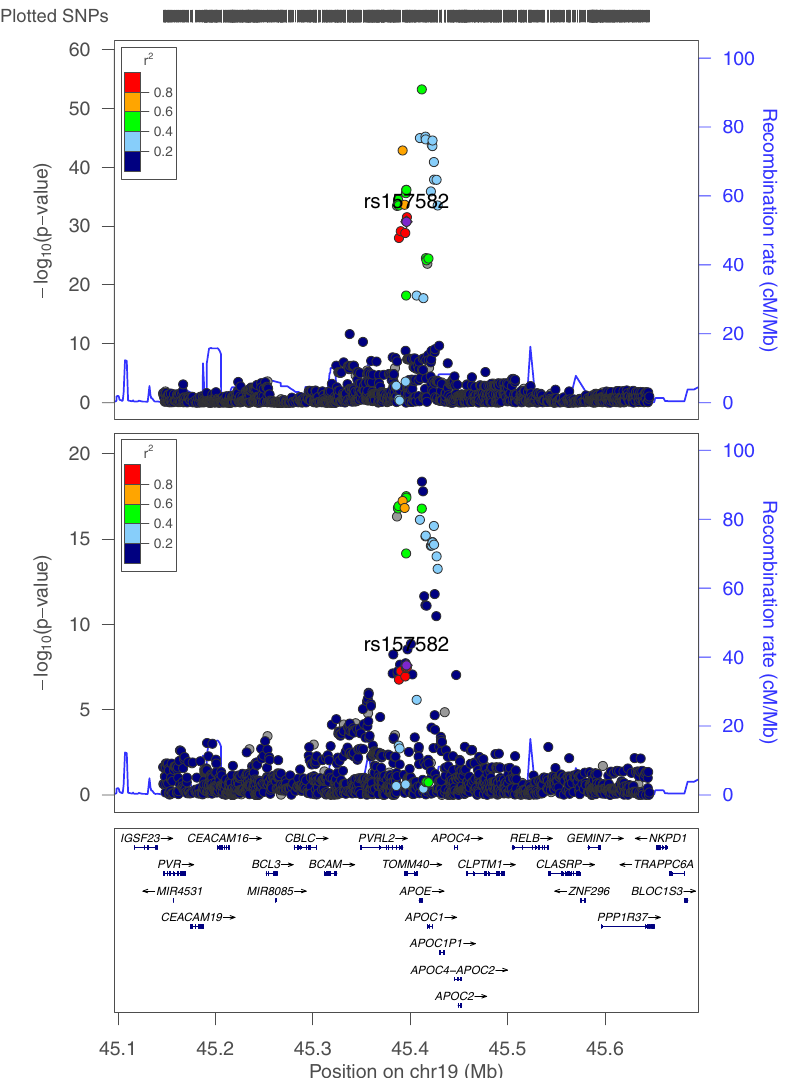
Fig. 6 Regional LD relationships near rs157582 locus on chromosome 19 from UKBB. The phenotype in the top plot is Alzheimer ’ s disease; and the bottom plot is atherosclerotic heart